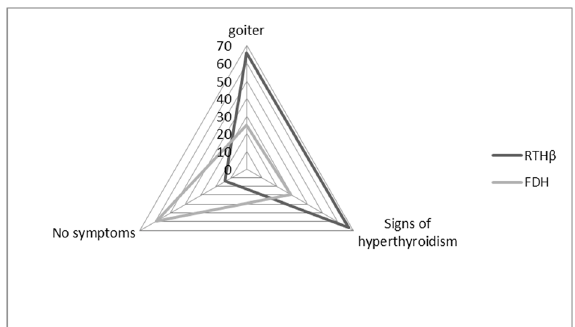
Figure 3. Distribution of the different clinical features among patient with RTH β and FDH. Radar plot showing the proportion of patients (%) with each clinical feature: goiter, signs of hyperthyroidism, or asymptomatic.